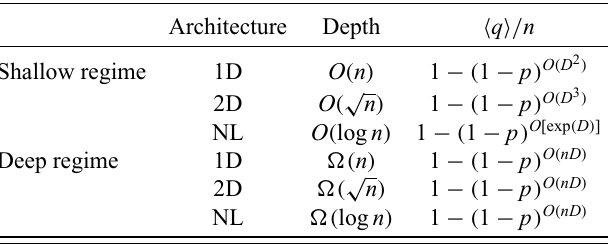
TABLE I. Summary of the scaling of the expectation value of the fraction of depolarized qubits at the end of the computation, as a function of the circuit depth and system size. We identify two different regimes: a shallow-depth regime and a deep regime. The deep regime represents the cases in which the light cone of a single error can reach the edges (i.e., a single error can propagate to all other qubits), while for the shallow regime circuits, this